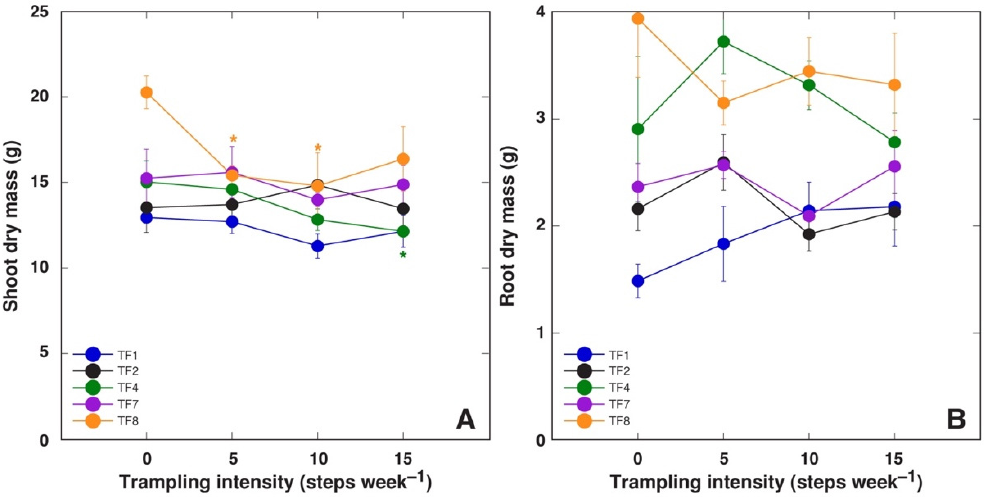
Figure 5. Effect of increasing trampling intensity on shoot dry mass ( A ) and root dry mass ( B ) of Trifolium fragiferum plants of different accessions. Measurements were performed after five weeks of treatment plus three weeks of recovery. Data are means ± SE from five plants. Asterisks indicate statistically significant difference ( p < 0.05) from control for the respective accession.